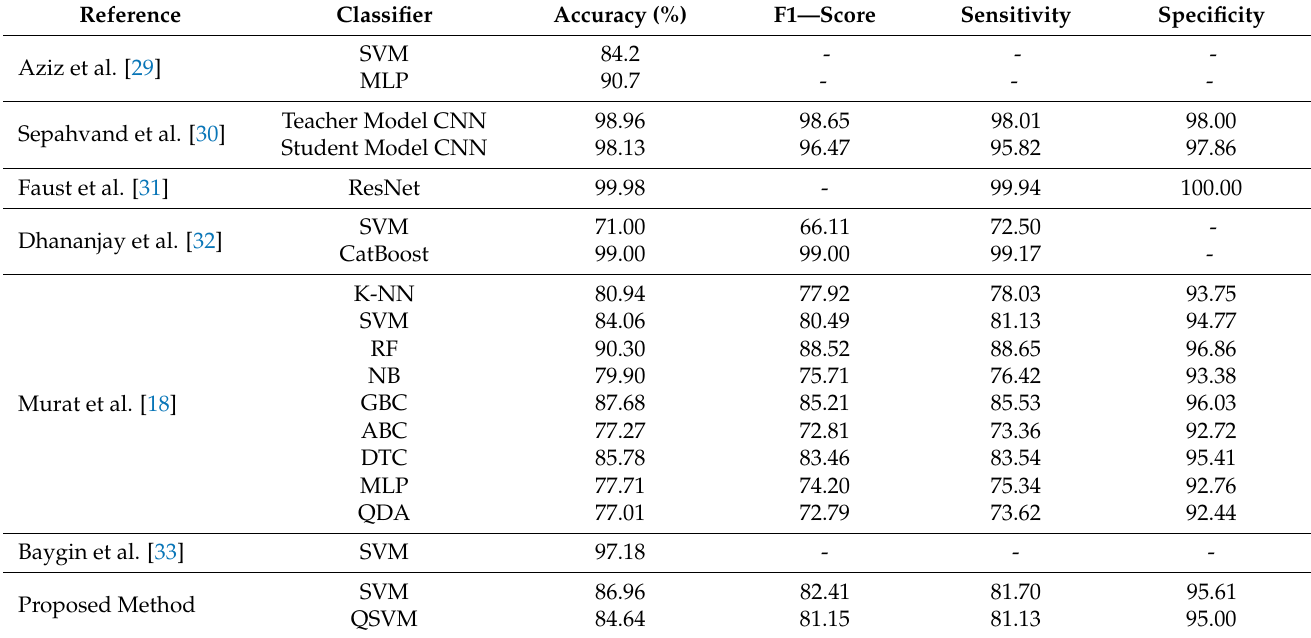
Table 5. Comparison of some studies with Chapman dataset and some metrics of the proposed